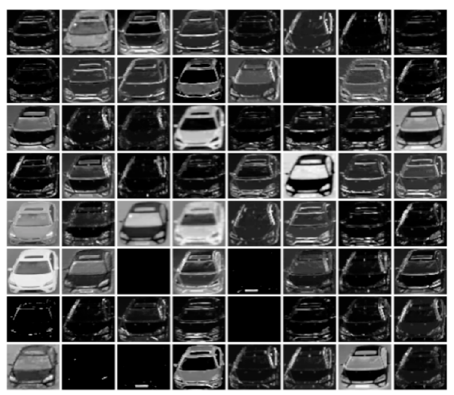
Figure 4. Vehicle characteristics after pooling and other operations.